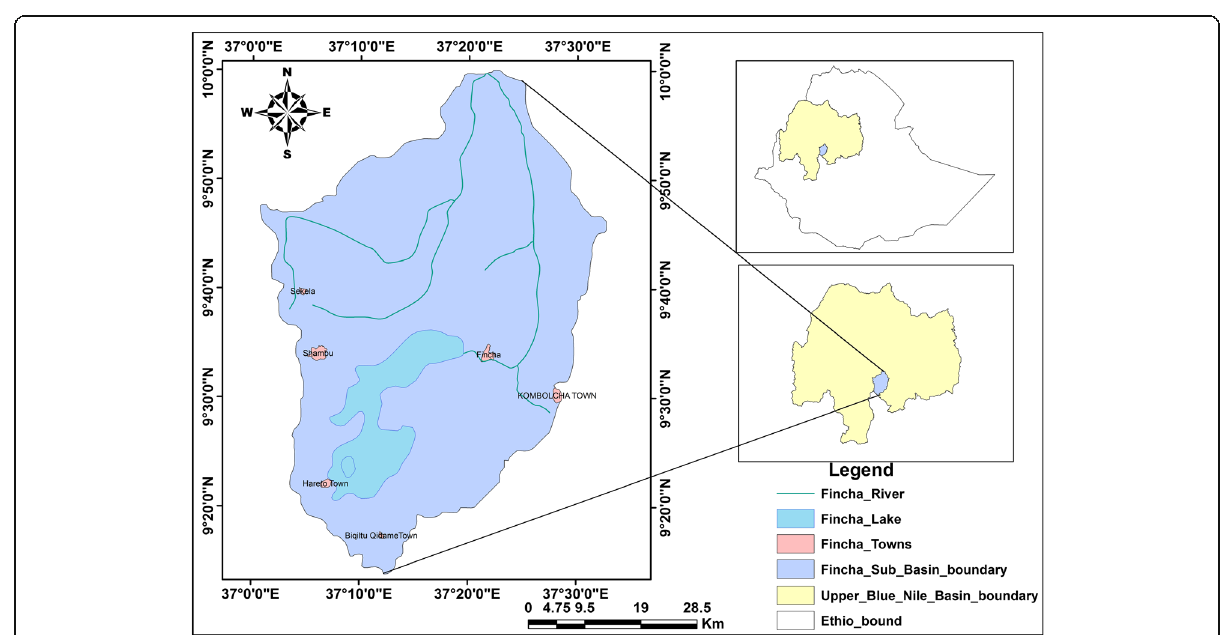
Fig. 1 Fincha ’ a sub-basin and its associated Blue Nile/Abay River